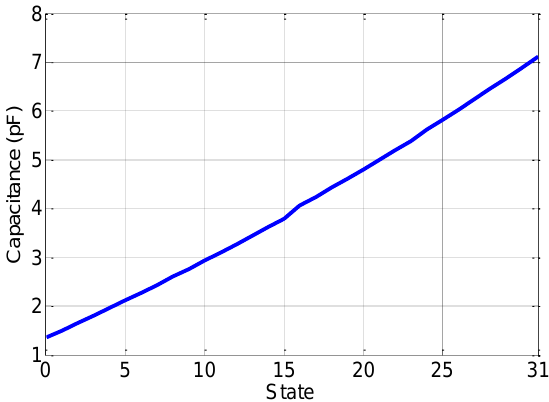
Figure. 2. Simulated Capacitance (@1 GHz) vs TC State in Shunt